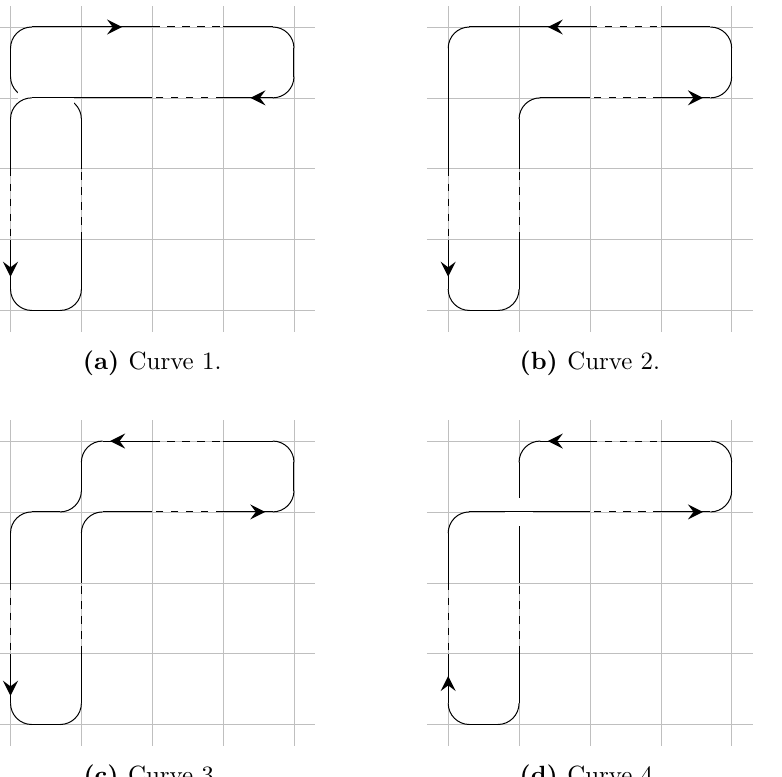
Figure 1 . Some typical paths for glueball operators built from rectangles. Each rectangle can be extended arbitrarily, so providing some curves with no overall rotational or re(cid:13)ection